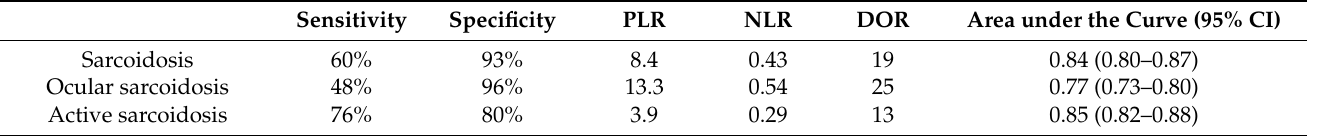
Table 3. The diagnosis performance of sACE by status of sarcoidosis.